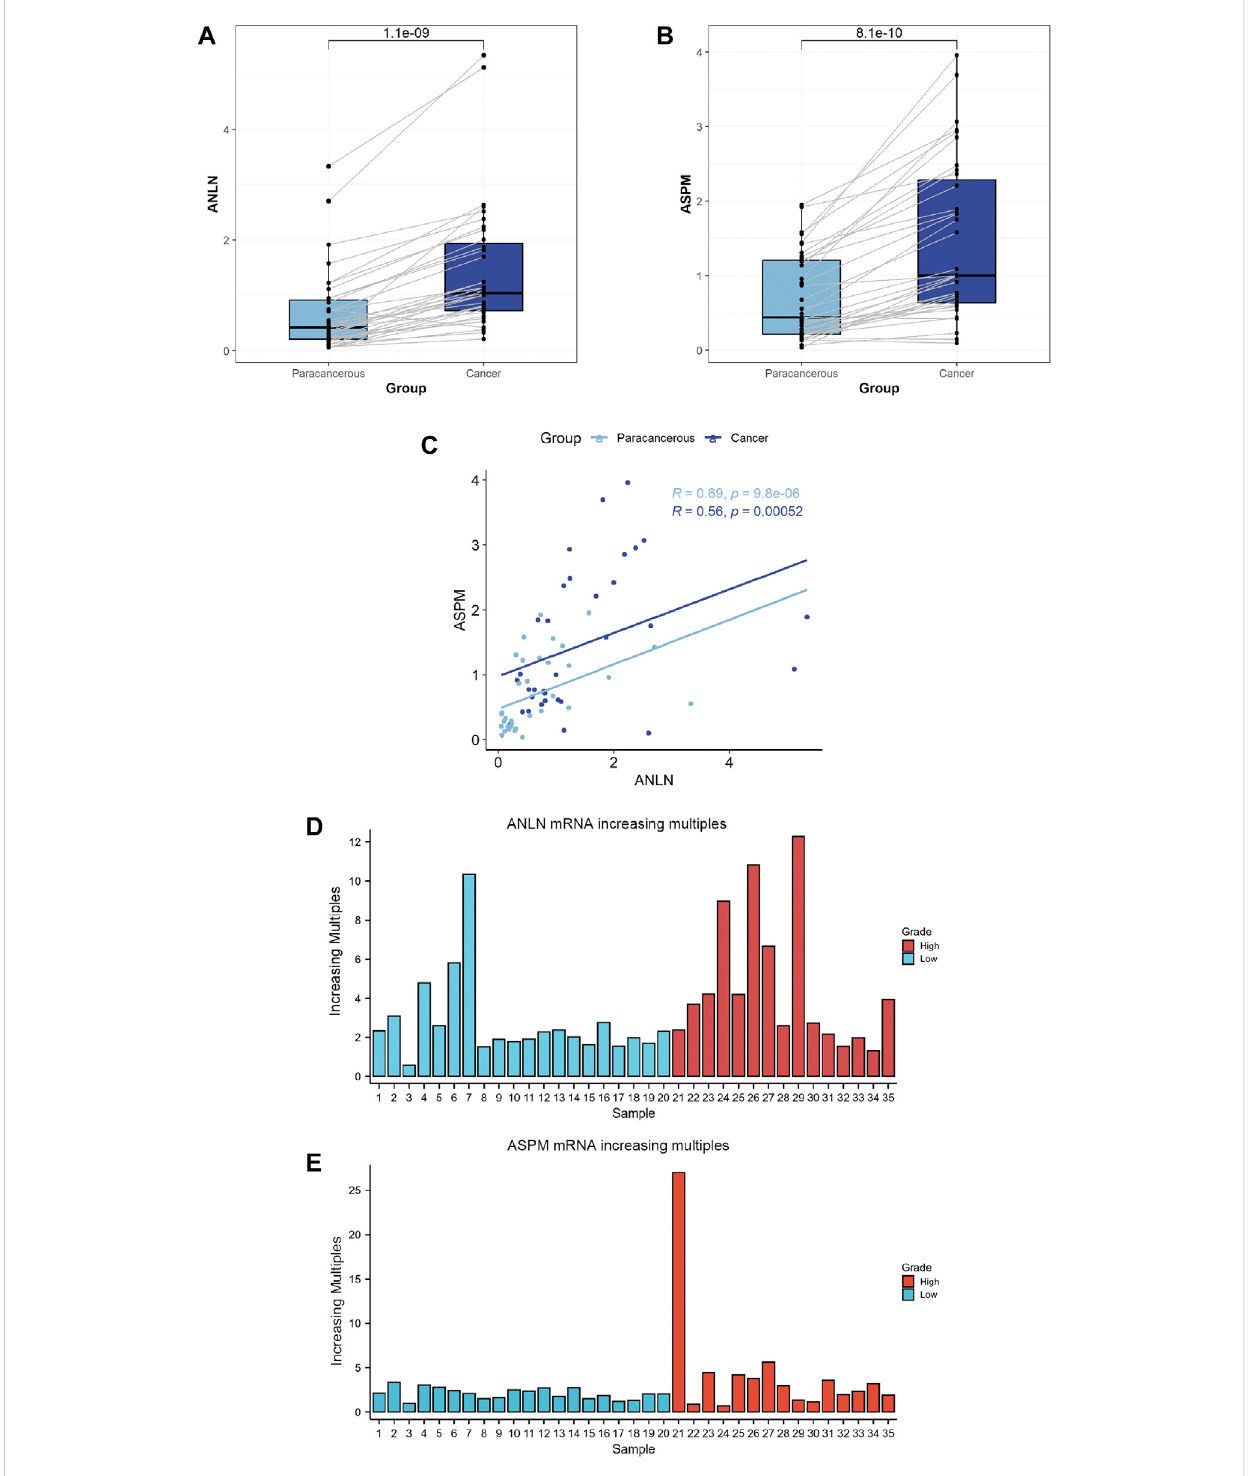
FIGURE 5 Comparison between bladder cancer tissues ( N = 35) and paracancerous tissues ( N = 35) according to the expression levels of ANLN (A) and ASPM genes (B) . Correlation between ANLN and ASPM in bladder cancer tissues ( N = 35) and paracancerous tissues ( N = 35) (C) . Comparison between bladder cancer tissues and normal tissues according to the increasing multiples in the mRNA expression levels of ANLN (D) and ASPM (E)